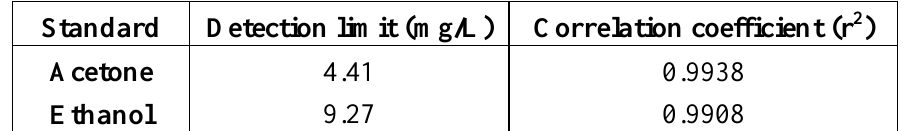
Table 1. Detection limit and correlation coefficient of acetone and ethanol (n=3)